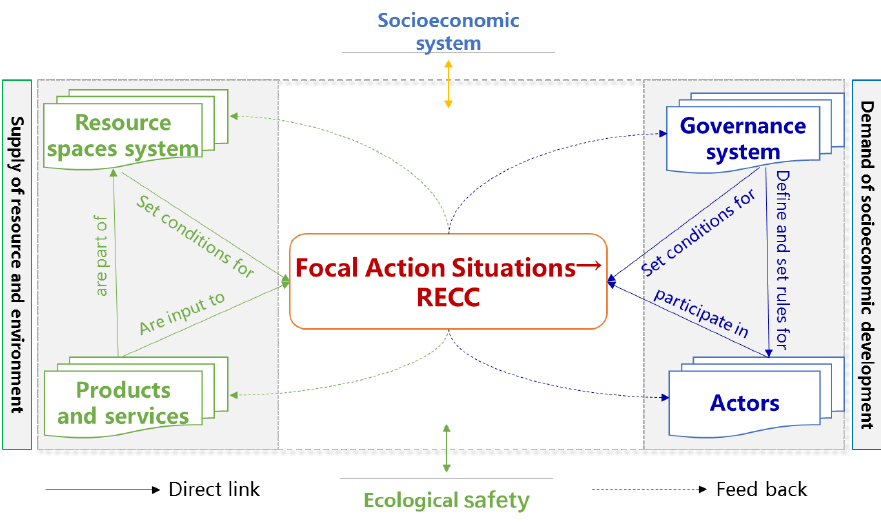
Figure 2. An SES framework of RECC. Note: Adapted from McGinnis et al. [54]. On the premise of ecological safety and socioeconomic sustainability, driving the dif- ferent demands of socioeconomic development, stakeholders extract resources and envi- ronmental products and services from the resources systems (e.g., water, construction land, cultivated land, ecological) according to the relevant rules. The scenarios vary from the different actions of stakeholders, including government, market, and organizations, incurring the change of socioeconomic development and the supplies of resources and the environment. While assessing RECC, we identify the difference between the supply and demand as the RECC state value. When the RECC value is negative, resources and envi- ronments are overloaded. When the RECC value is positive, the resources and environ- ments are loadable. When supply and demand are infinitely close to zero, they are infi- nitely close to a coordinated and balanced state between resources and environments and socioeconomic development. Each subsystem makes dynamic adjustments according to the RECC value feedback to ensure coordinated operation between the social and ecolog- ical system. Six subsystems are described as follows: